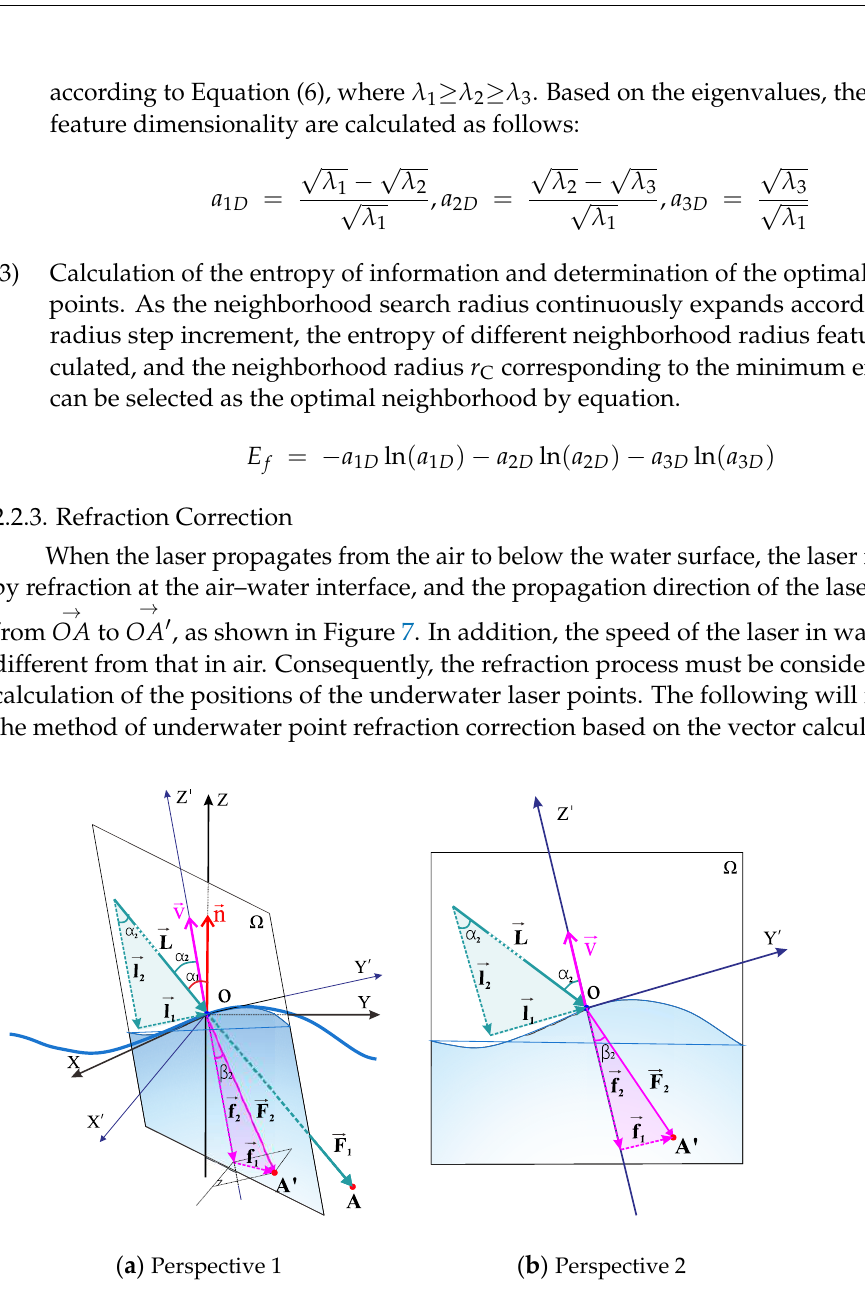
Figure 7. Laser refraction on a water surface undulation.